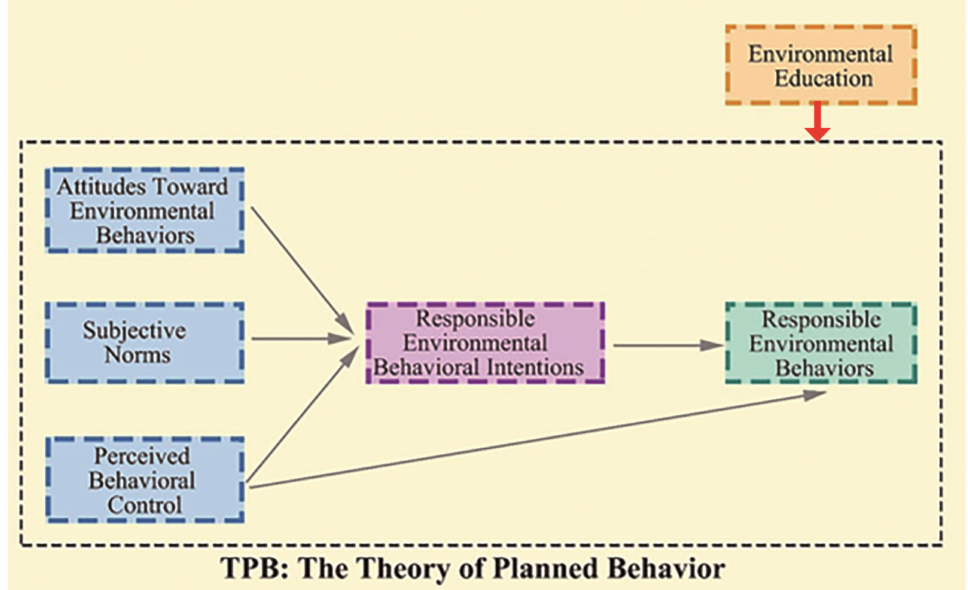
Figure 3. Structure of the relationship between situational environmental education and theory of planned behavior (TPB)